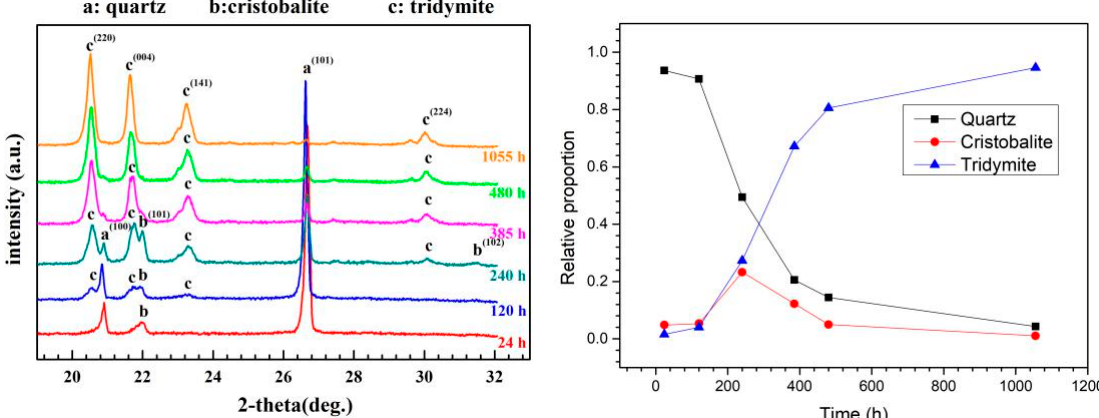
Figure 7. Phase evolution of coarse quartz—potassium silicate glass composites after holding at 900 °C for different time.